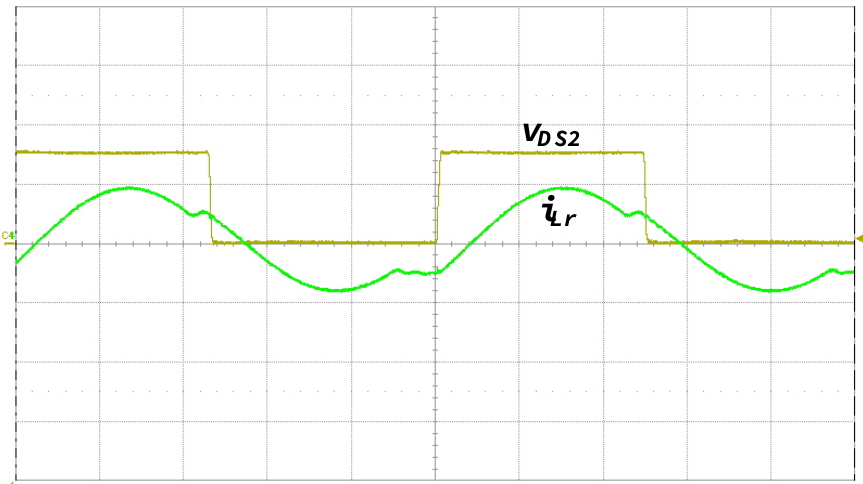
Figure 9. Measured switch voltage v DS 2 (200 V/div) and current i DS 2 (2 A/div); time scale: 2 μs/div.